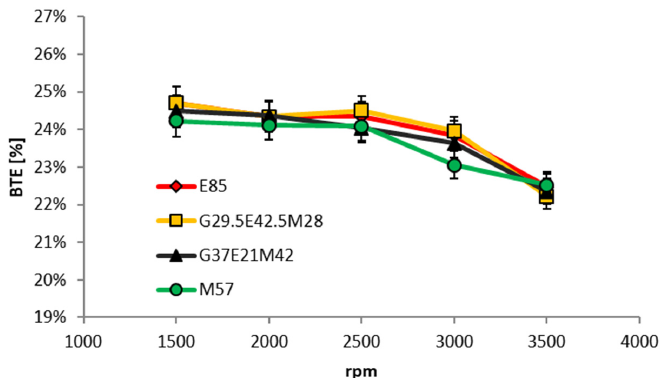
Figure 12. BTE of various iso-stoichiometric GEM blends as a function of engine speed for a fixed brake torque of 40 Nm (2.82 bar BMEP).